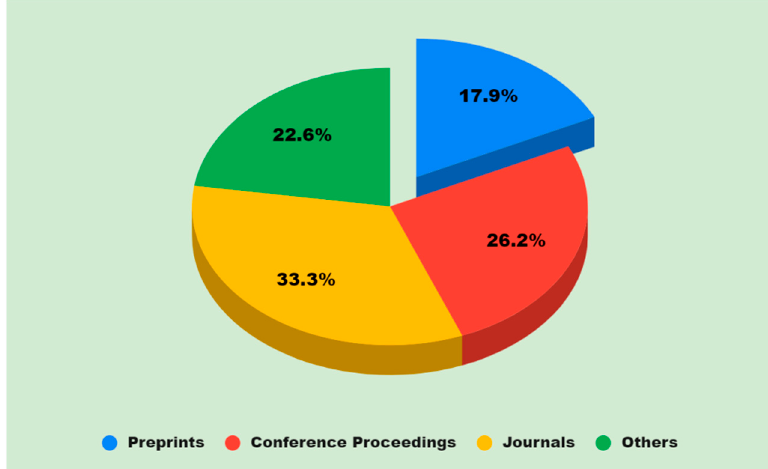
Figure 3. Number of publications per year.